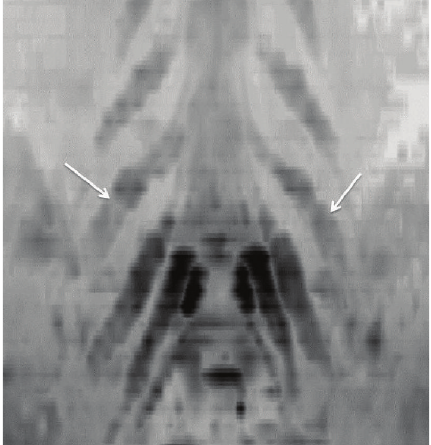
Figure 8: 3D functional nerve selective MRN-Coronal MIP (inverted grey scale contrast) from a 3D DTI using single shot EPI ( 𝑏 values 0, 600s/mm 2 and 20 directions of interrogation) shows the symmetrical enlargement of bilateral LS plexus nerve roots (arrows) in a known case of hereditary motor and sensory neuropathy with diffusely reduced FA values in bilateral